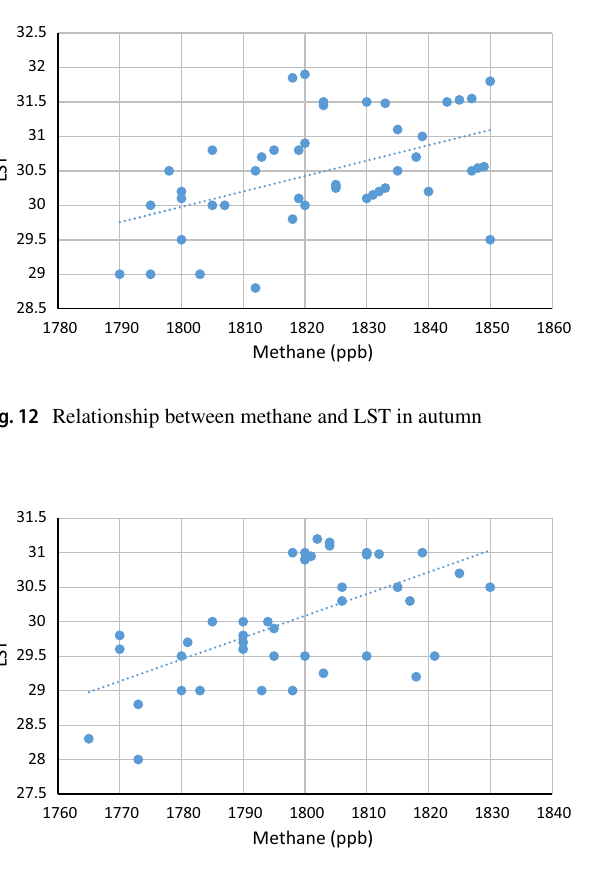
Fig. 13 Relationship between methane and LST in